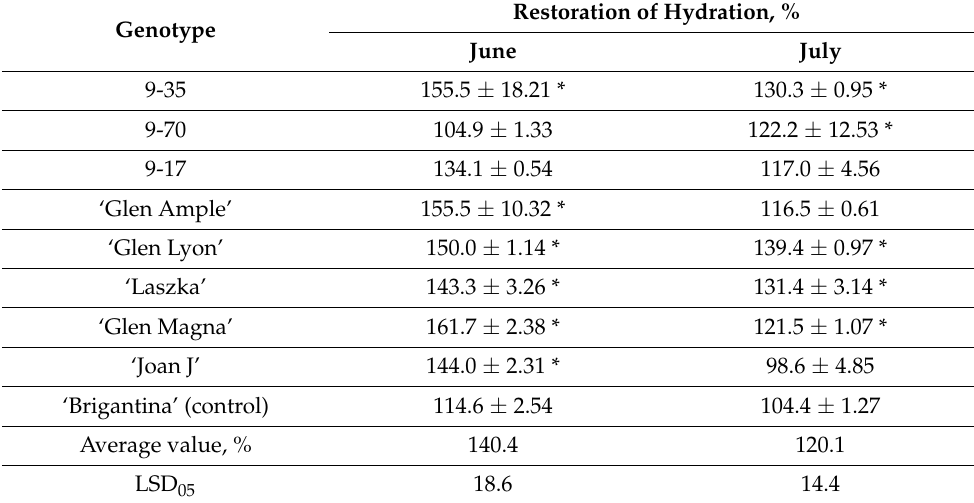
Table 7. Restoration of hydration of raspberry leaves after drought simulation, % (2019–2021).